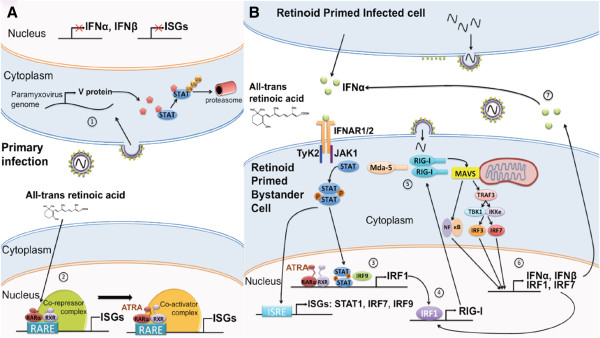
Retinoid action during paramyxovirus infection. (A) 1) Jak/STAT signaling is inhibited as a result of viral infection and ATRA treatment is unable to effectively promote unregulation of ISGs and type I IFN production. 2) Cells exposed to the products of the primary infection and primed with ATRA can more efficiently secrete type I IFN upon infection. (B) 3) Exposure to ATRA and type I IFN in the supernatant signals through the Jak/STAT pathway with the combination of nuclear localization of STAT1/2 heterodimer and activation of the RAR/RXR complex results in the transcription of multiple ISGs, importantly IRF1. For simplicity, only IFNα and its receptor IFNAR1/2 are shown to promote Jak/STAT signaling. 4) RIG-I expression is greatly up-regulated under these conditions, by IRF1 binding to the interferon response element (IRE) on its promoter. 5) Increased cytoplasmic quantities of RIG-I provide protection in the bystander cell upon virus infection. RIG-I detects viral RNA and associates with the adaptor protein MAVS, which initiates downstream activation of NFκB and IRF3/7. Nuclear translocation to their respective promoter elements induces transcription of antiviral genes, i.e., type I IFN and IRF1/7 production. It is not clear what role the second cytoplasmic RNA helicase (mda5) plays in this cascade although mda5 has been implicated in responses to several Paramyxoviridae. 6) These proteins feedback onto their respective pathways and promote RIG-I expression, further improving the antiviral state of the cell. 7) Increased production of type I IFN from the retinoid-primed bystander cell provides both an autocrine and paracrine signal to further protect the uninfected cells in culture.